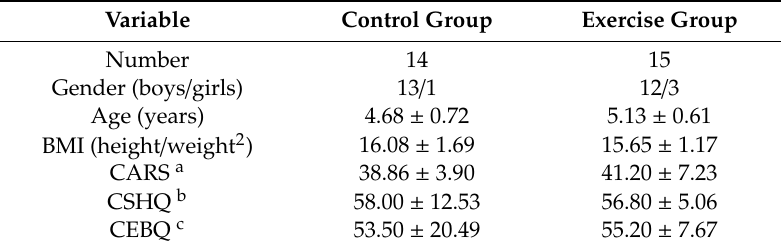
Table 3. Participants’ characteristics (mean ± standard deviation).